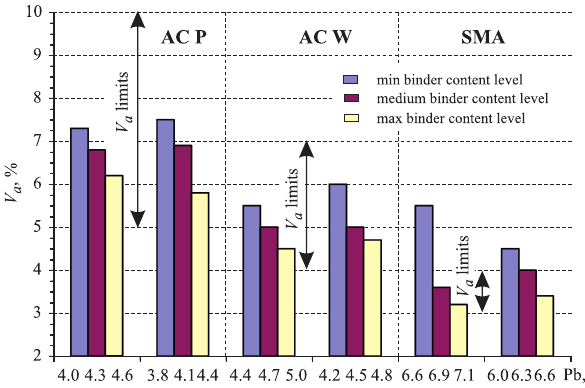
Fig. 5. Air voids determination for different mixes and binder